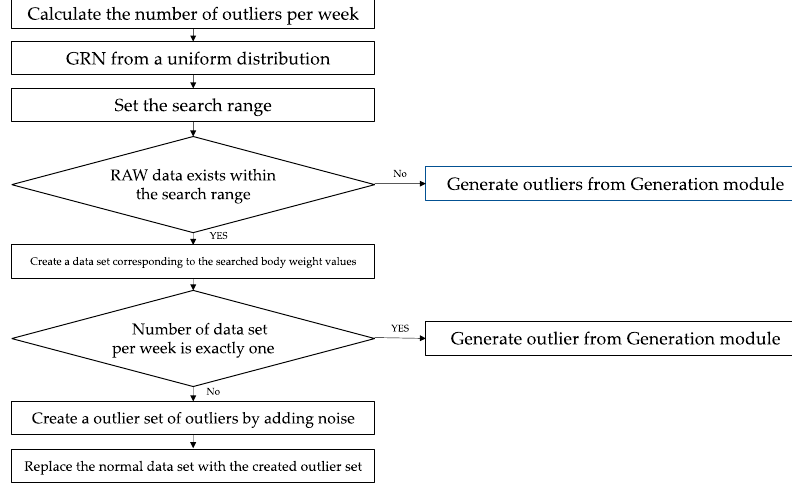
Figure 2. The Search module: An outlier generation module based on data set exploration, this is a flowchart of the search flowchart of the search module.